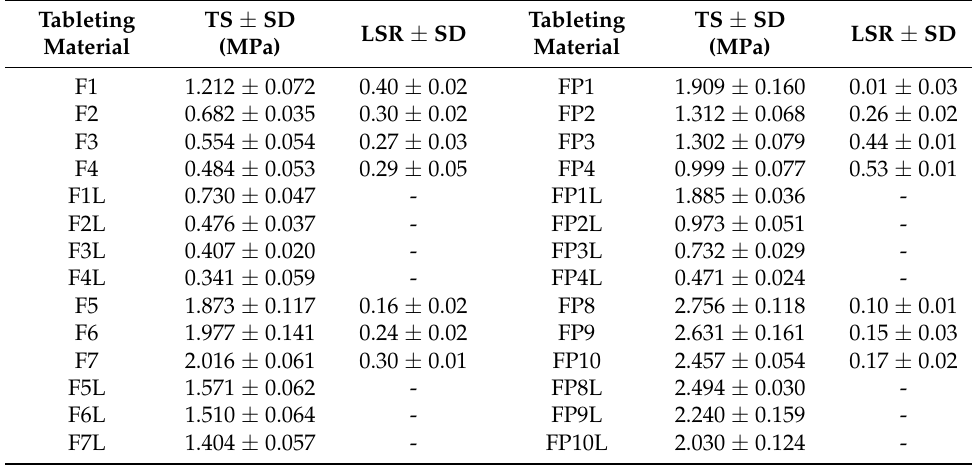
Table 5. Values of tensile strength and LSR of tableting